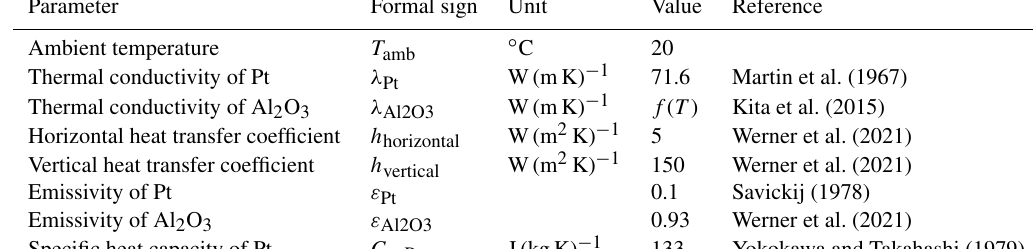
Table 1. Simulation boundaries.